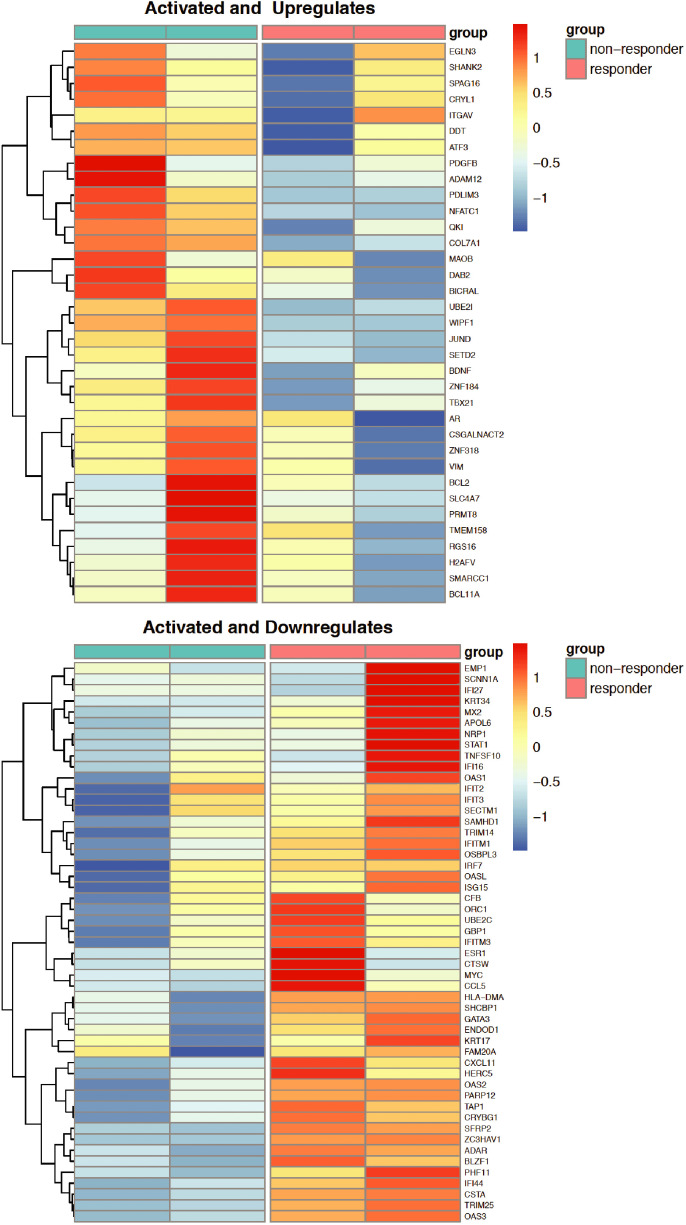
Expression pattern of MAPK-target genes in responder and non-responder TNBC patient-derived breast cancer cases.Red and blue colors indicate high and low gene expression, respectively.